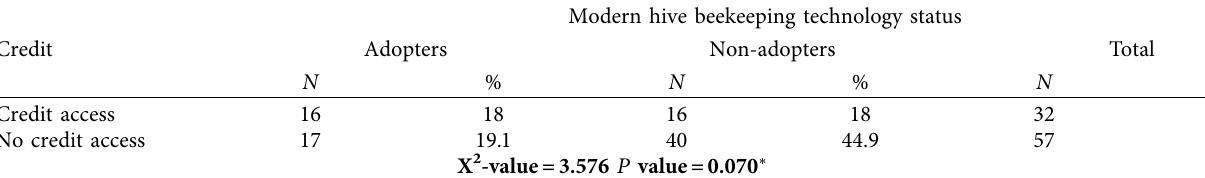
Table 12: Distribution of credit access.